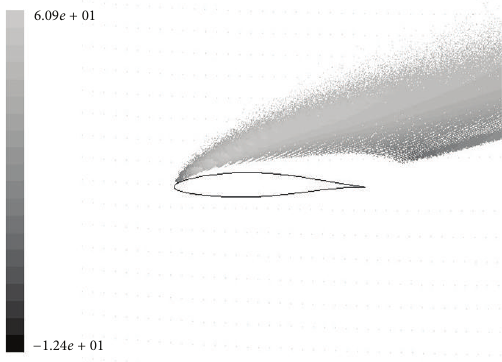
Figure 17: Raindrop traces at AOA = 16 degree.